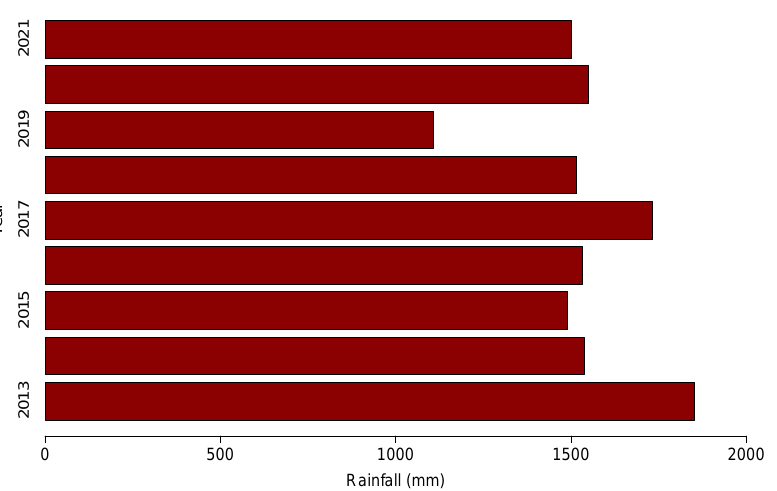
Figure 6. Annual precipitation in Coatzacoalcos, Veracruz. Source: Comision Nacional del Agua (CONAGUA) [74].